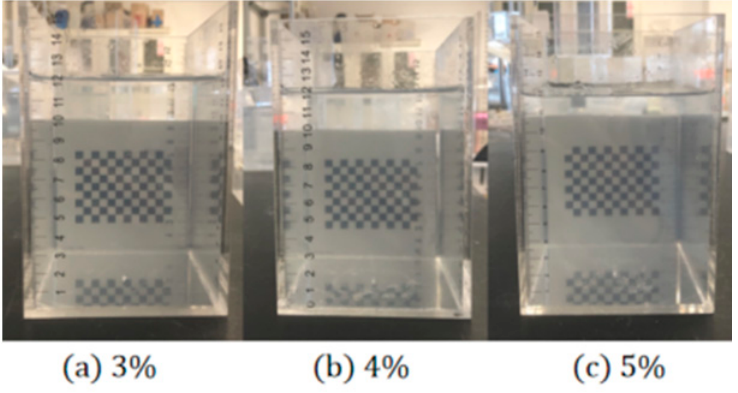
Figure 1. Samples of MLPS transparent soil.